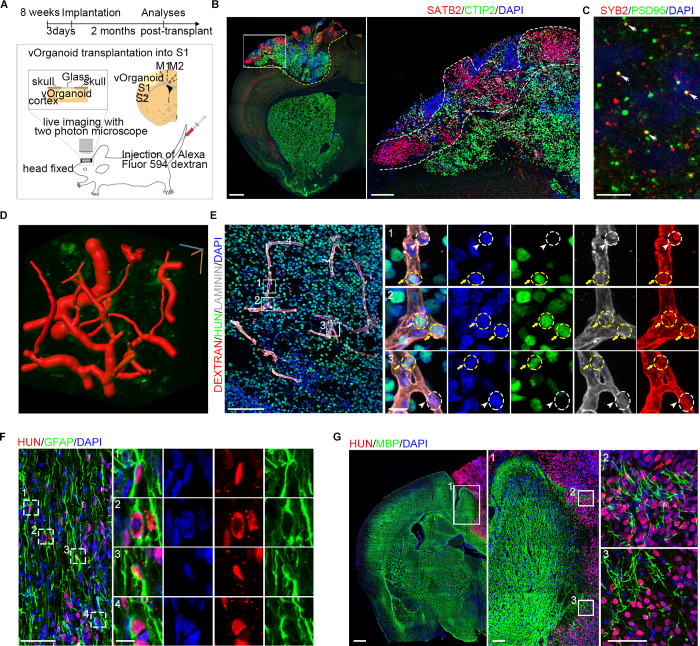
The vOrganoids play important roles in the reconstruction of vascular system after transplantation.(A) Schematic diagram to demonstrate the vOrganoids implantation protocols in our studies. The vOrganoids were transplanted into the S1 cortex of NOD-SCID mice. (B) Representative immunofluorescence staining figure for the classical cortical layer markers, CTIP2 and SATB2, at 2 months postimplantation. The boxed area was magnified in the right panel. Scale bar, 500 μm (left), 50 μm (right). (C) Representative immunofluorescence staining figure for presynaptic (SYB2) and postsynaptic (PSD95) in the vOrganoid grafts of 60 dpi. The displayed area was close to the graft–host border. The colocalization (arrowheads) and close association of SYB2 and PSD95 indicate that synaptic connectivity emerges in the organoid grafts. Scale bar, 10 μm. (D) The blood vessels in the vOrganoid grafts were reconstructed in three dimensions. The red tubular structure was blood vessels. Scale bar was labeled at three dimensions. Scale bar, 30 μm. (E) Immunofluorescence staining for LAMININ, dextran, and HUN were performed to confirm that the human ECs derived from vOrganoids (labeled by yellow circles and yellow arrows) and the mice ECs derived from hosts (labeled by white circles and white arrowheads) were both detected in the vascular systems in the vOrganoid grafts. Scale bar, 100 μm (left), 10 μm (right). (F) Representative immunofluorescence staining figure for GFAP and HUN in the vOrganoid grafts. A few HUN-positive astrocytes were labeled by boxes and magnified in right panels. Scale bar, 50 μm (left), 10 μm (right). (G) Representative immunofluorescence staining figure for MBP and HUN to illustrate that myelinization just could be infrequently observed at the border of graft-host commissure. The boxed areas were magnified. Scale bar, 500 μm (left), 100 μm (middle), 50 μm (right). See also S4 Fig. CTIP2, chicken ovalbumin upstream promoter transcription factor (COUP-TF)–interacting protein 2; dpi, days postimplantation; GFAP, glial fibrillary acidic protein; HUN, human nuclear; MBP, myelin basic protein; NOD-SCID, nonobese diabetic severe combined immunodeficient; PSD95, postsynaptic density protein-95; SATB2, SATB homeobox 2; SYB2, synaptobrevin 2; vOrganoid, vascularized organoid.